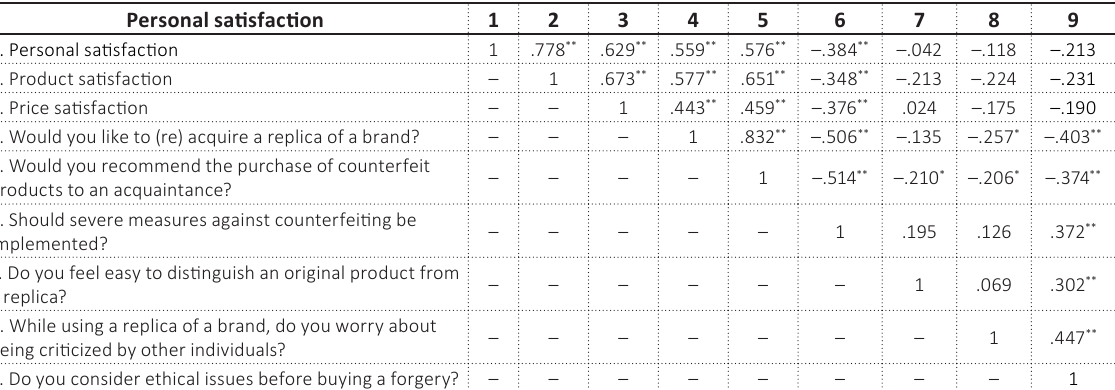
Table 4. Relationship between experience, intention/recommendation, and ethical/legal issues related to